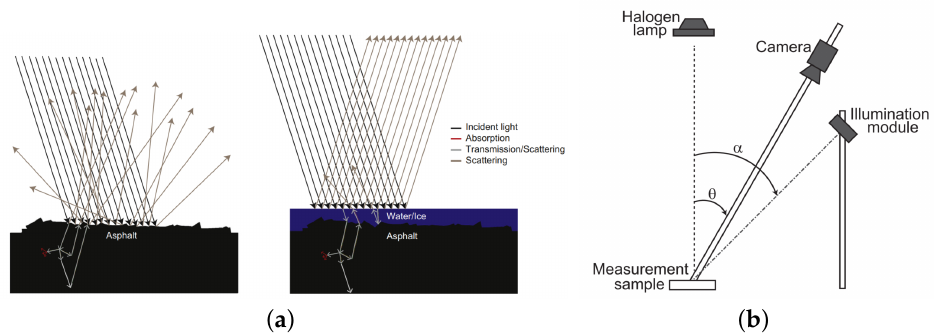
Figure 5. ( a ) Scattering of light incident on rough and smooth road surfaces. ( b ) Experimental setup with a halogen lamp (placed directly above the sample), a camera with an adjustable aperture lens, and an illumination module respectively mounted at angles equal to 30 and 45 degrees diagonally [17].